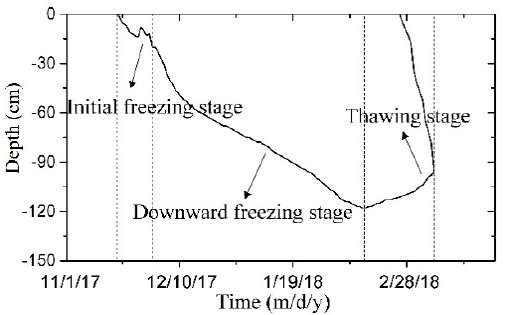
Figure 10. The freezing depth curve during the freeze-thaw process.